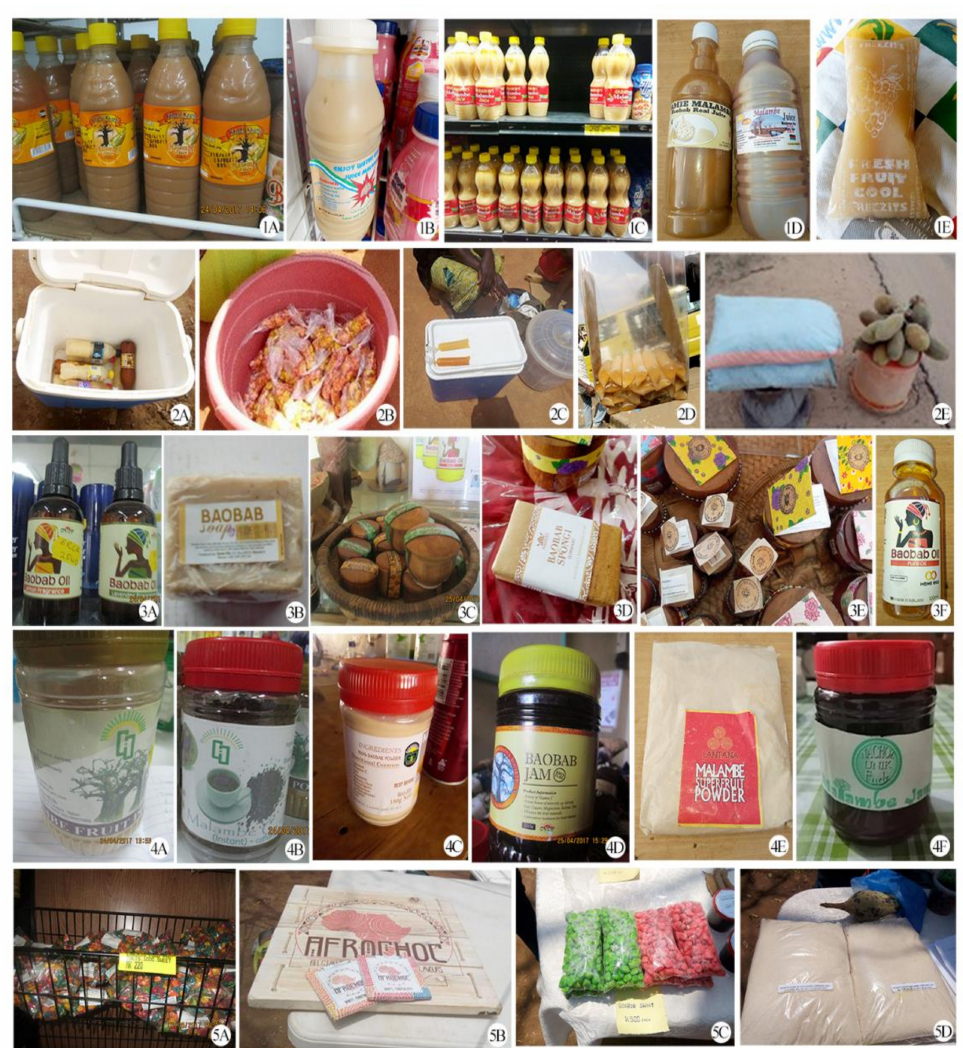
Figure 2. Examples of baobab products from the Malawian formal and informal markets. 1A – D